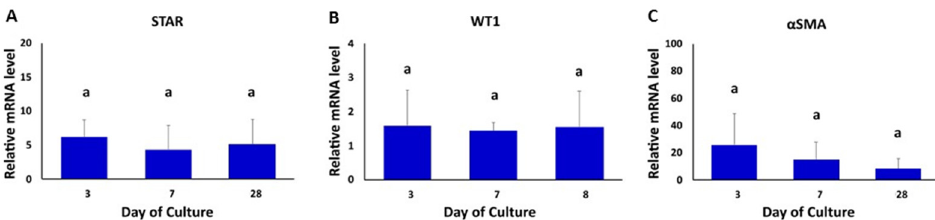
Figure 3. Gene expression analysis of testicular cell-specific markers in bovine TOs. ( A – C ) The gene expression levels of STAR (Leydig cells), WT1 (Sertoli cells) and α -SMA (peritubular myoid cells) were not different ( p > 0.05) in TOs at days 3, 7 and 28 of the culture. β -ACTIN was used as a housekeeping gene. Gene expression values were normalized (fold-change) with respect to values in testicular cells isolated prior to the formation of TOs (control). Data were expressed as the mean ± SEM ( n = 3). Superscript (a) indicates no significant ( p > 0.05) differences in gene expression among days of culture.